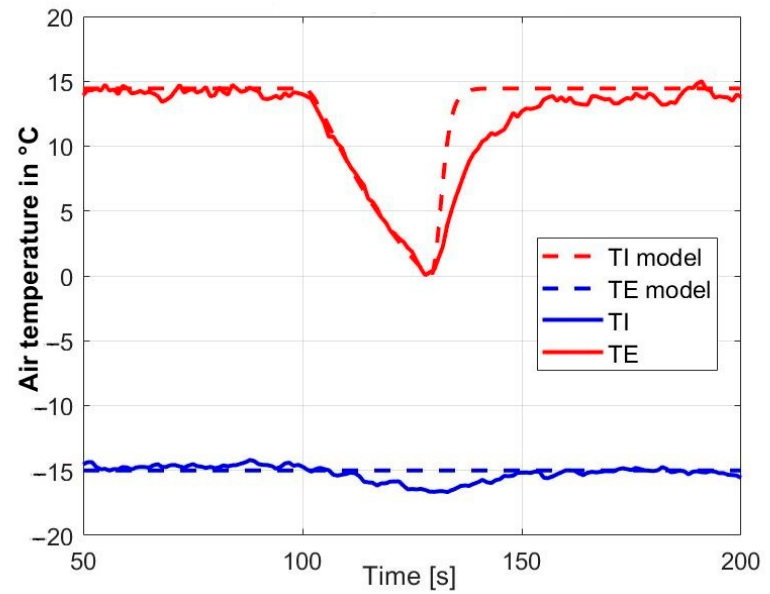
Figure 14. Diagram of comparison between model and experimental data for a number of sections n = 15 for air temperatures.